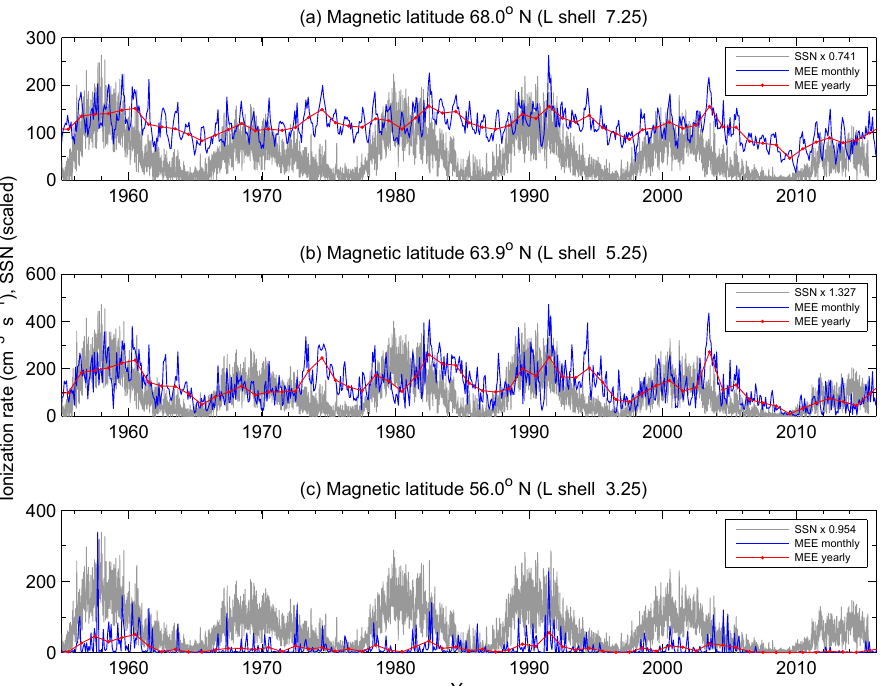
Figure 14. Examples of solar-cycle variability of modeled, Ap-driven MEE ionization at ≈ 80km altitude, with comparison to the sunspot number variability (SSN,